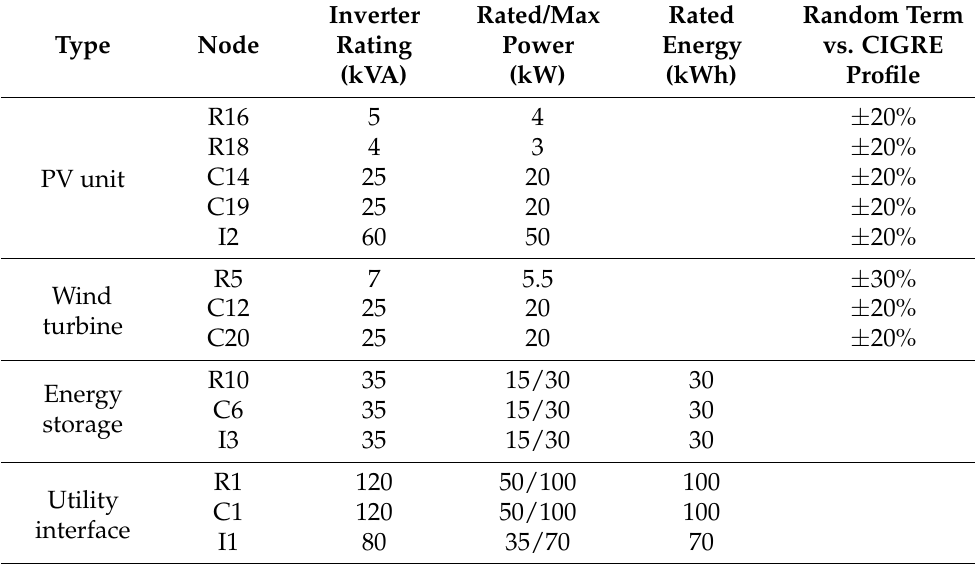
Table A3. Characteristics of the distributed energy resources considered in the application example in Section